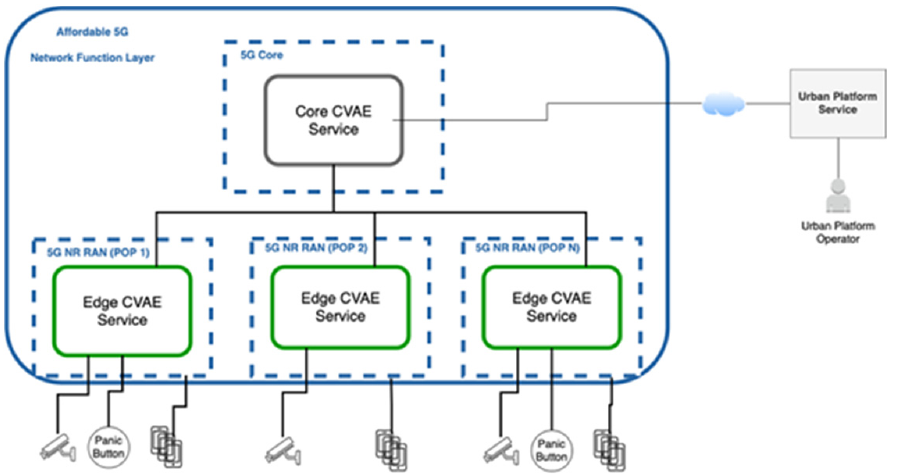
Figure 9. CVAE High Level Overview.